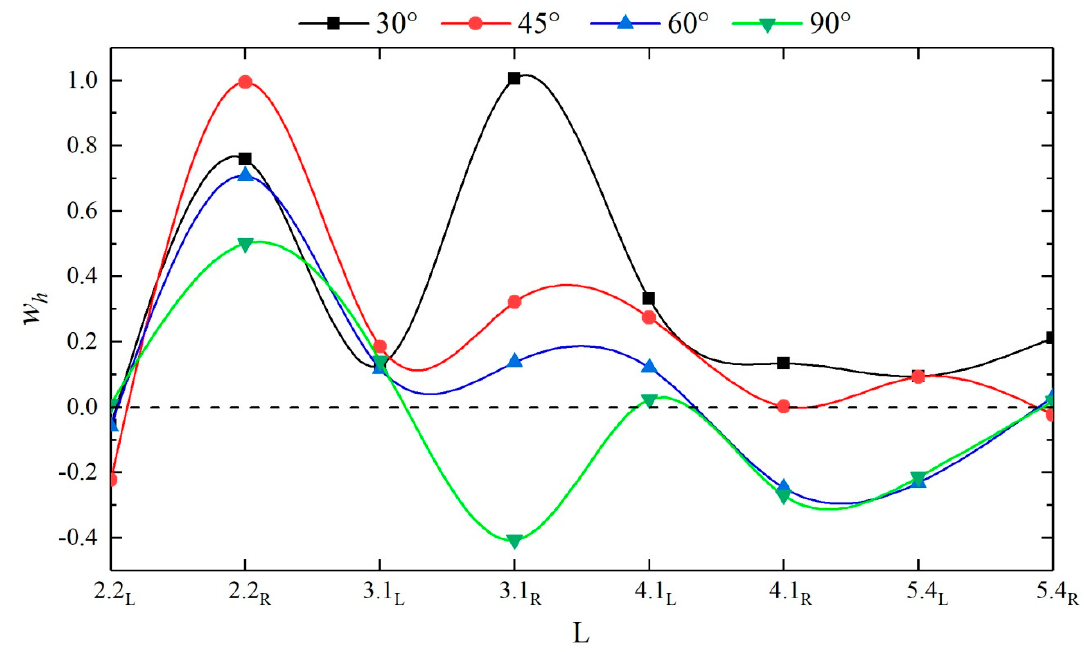
Figure 10. w h values at each measuring point in the downstream straight sections of different configurations.